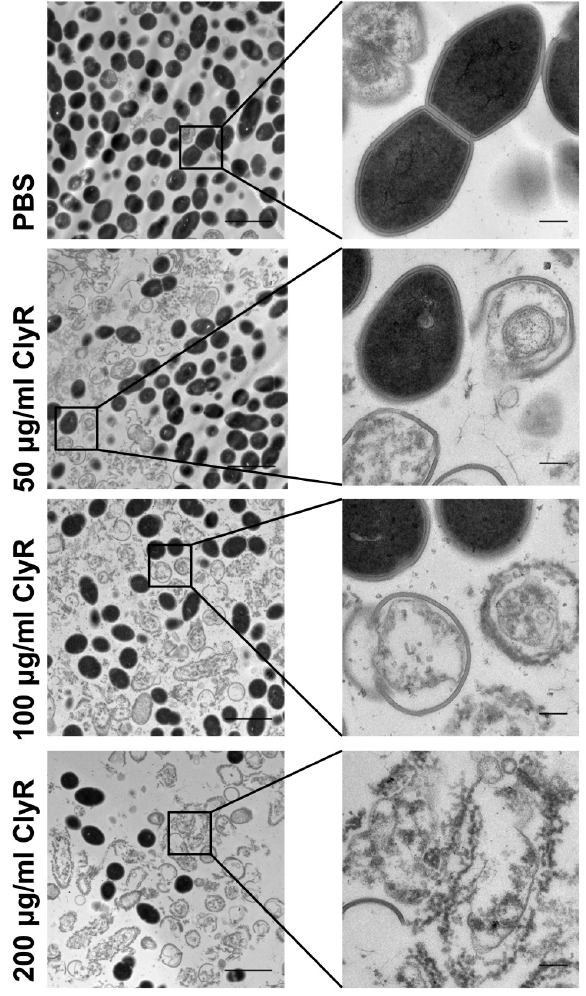
Figure 2. Morphology of E. faecalis after exposure to ClyR. E. faecalis ATCC 51299 cells are washed with PBS and treated with various concentrations of ClyR (0, 50, 100, and 200 µ g/mL) for 1 h at room temperature. The morphology of bacterial cells after each treatment is observed by TEM. Scale bars: left panel: 2 µ m; right panel: 20